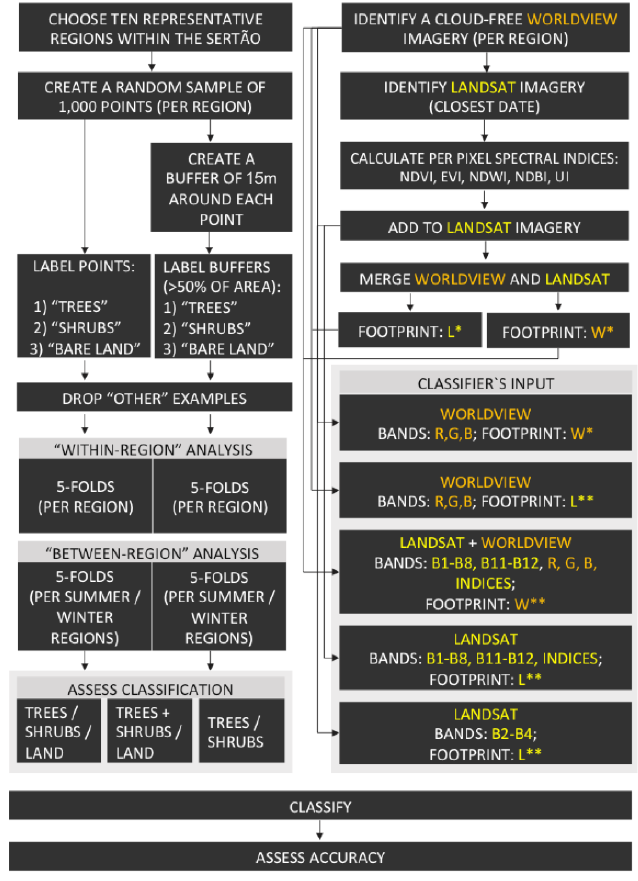
Figure 1. Methods flow chart for labeling and